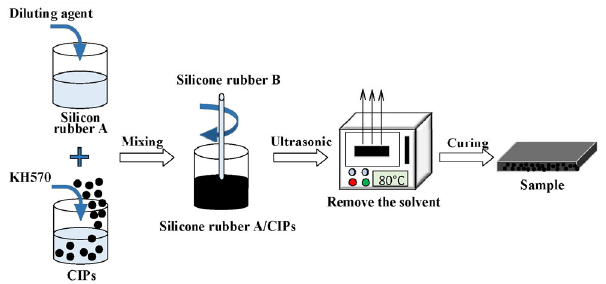
Fig. 9 The preparation process of MRE samples.